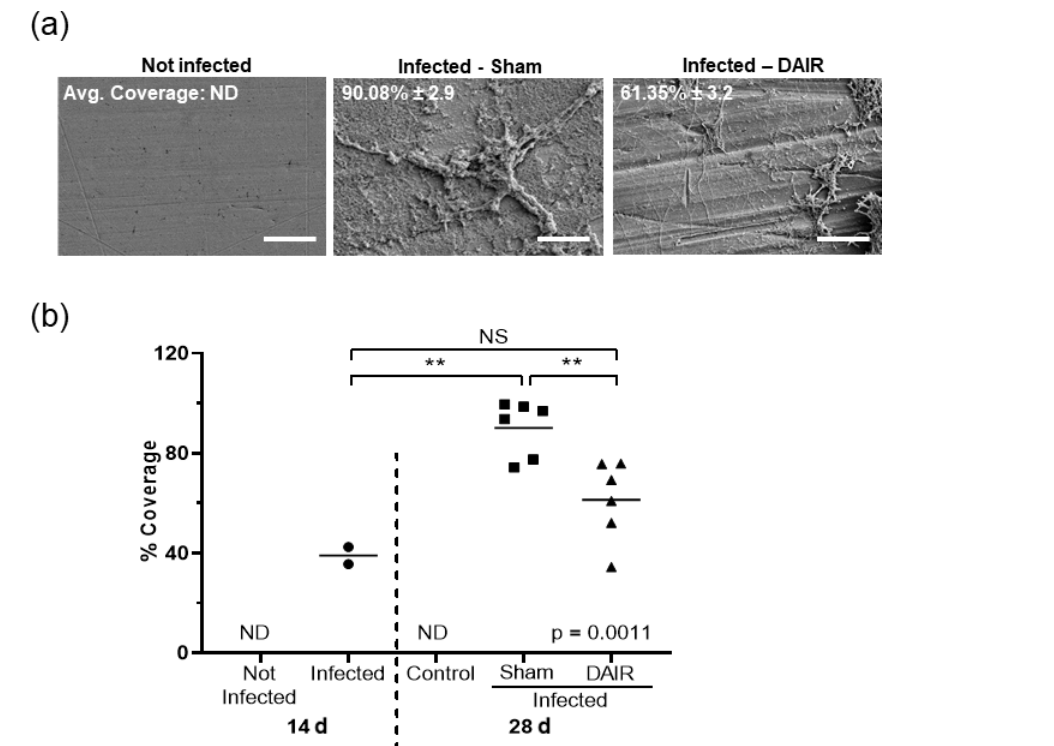
Figure 6. Panels (a) and (b) present the SEM analysis of biofilm coverage. Panel (a) shows representative SEM images of biofilm coverage at 28d at 1500 × magnification (scale bar 40µM). The average coverage is shown as the mean ± SE. Panel (b) presents plots depicting the percent coverage at 14 and 28d after infection. Each dot is the average of the 20 points analyzed on each implant ( n = 2–3 at 14d; n = 2 for the control and n = 6 for sham and DAIR at 28d from the two experimental treatments). ND: not determined; NS: not significant. The ANOVA p value was p = 0.0011, and ∗∗ denotes p <